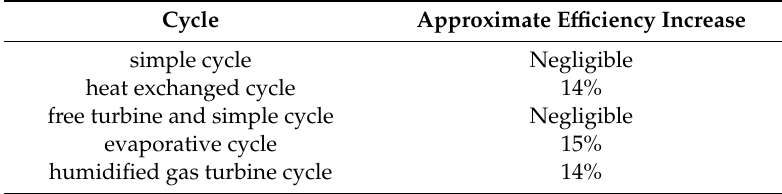
Table 2. A sample results of increasing turbine temperatures from 800 K to 1200